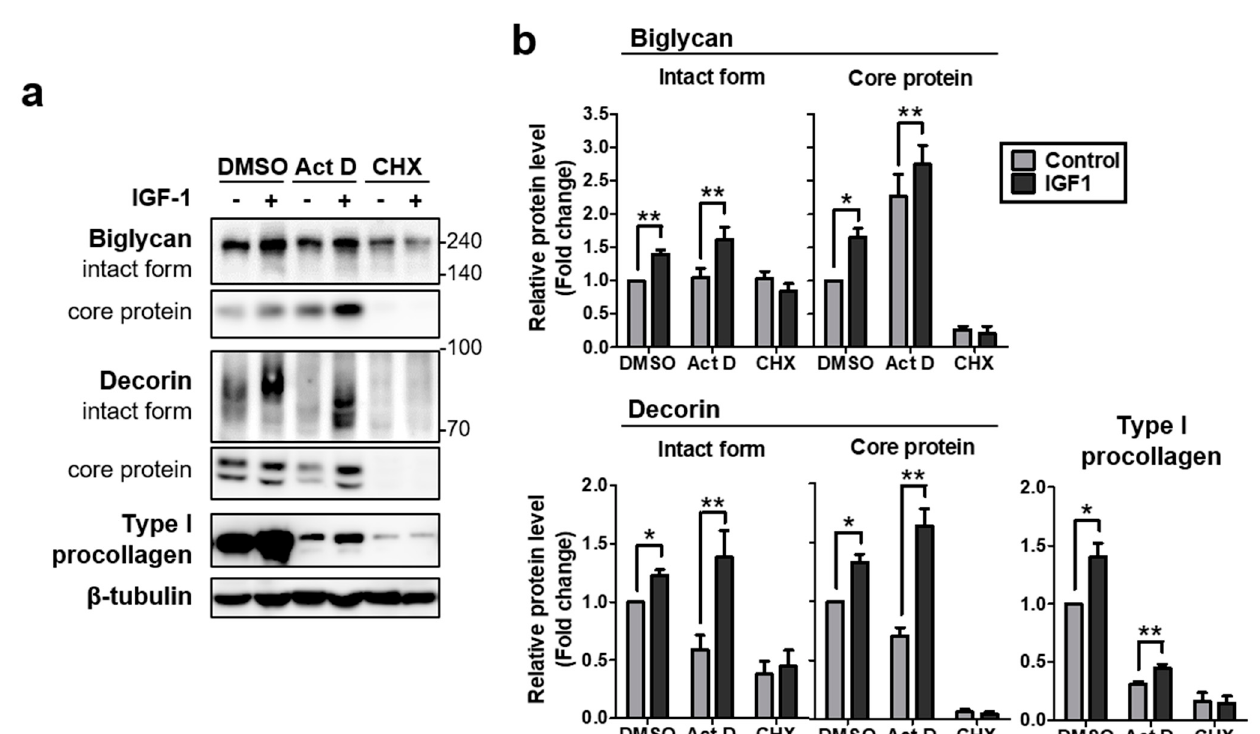
Figure 2. IGF-1 increased the protein levels of biglycan and decorin by upregulating protein translation in NHDFs. ( a ) Primary NHDFs were treated with actinomycin D (Act D, 1 µg/mL) or cycloheximide (CHX, 25 µg/mL) under basal conditions or in the presence of IGF-1 (250 ng/mL) for 18 h. Proteins of conditioned media and cell lysates were analyzed by western blotting. ( b ) Relative protein amounts were analyzed using ImageJ. Band intensity was normalized to that of β -tubulin. Values represent the mean ± SEM of data ( N = 4). Statistical comparison was made using paired t -test. (* p < 0.05, ** p < 0.01).